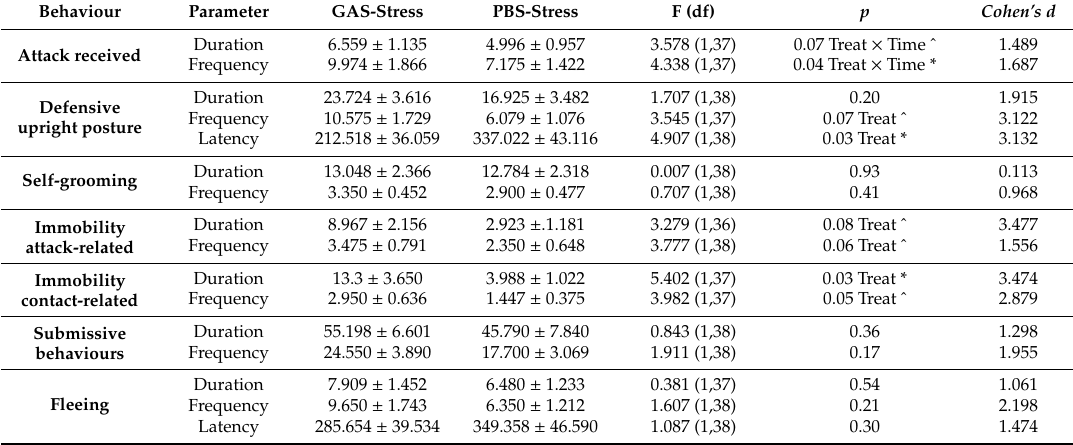
Table 1. Analysis of the behavioural profile during the 1st active agonist confrontation in the psychosocial stress procedure. Submissive behaviours = crouched posture + submissive posture. Duration = time spent (s) performing the behaviour, expressed as a mean of two 5-min intervals. Values are means ± SD; N = 9–10 per group. * p < 0.05, ˆ trend, df = degrees of freedom. Parameter GAS-Stress PBS-Stress Cohen’s